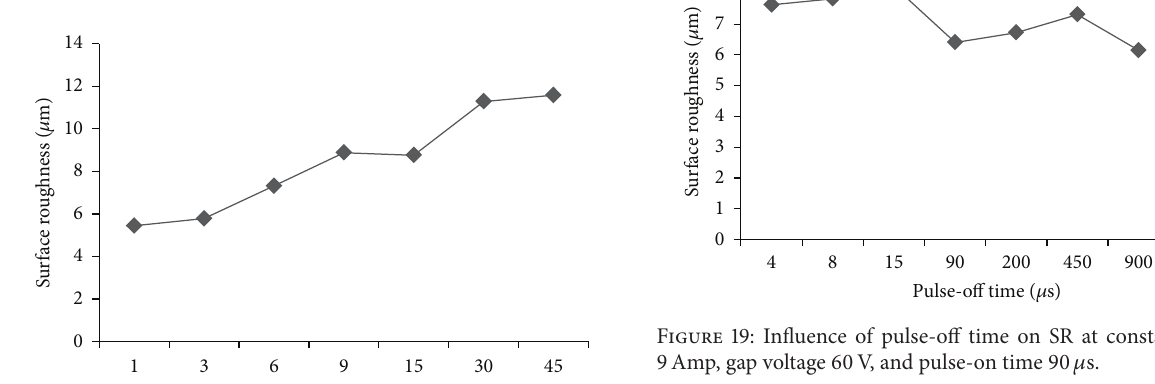
Figure 16: Influence of gap voltage on TWR at constant current 9Amp, pulse-on time 90 𝜇 s, and pulse-off time 90 𝜇 s.